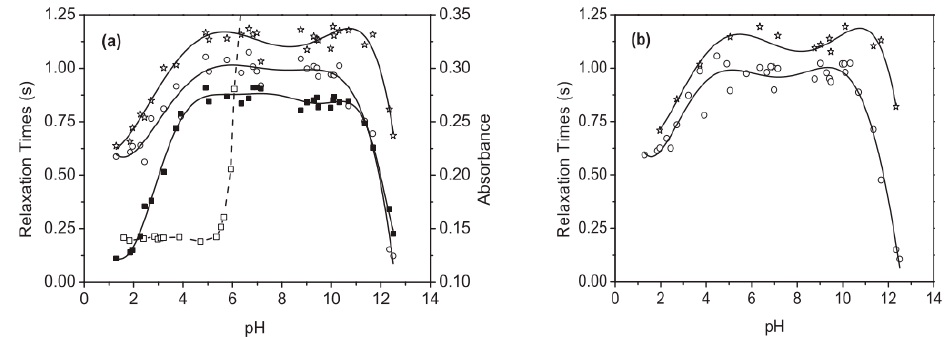
Figure 13. ( A ) Variation in maximum absorbance at 730 nm ( ■ ), T 1 ( ☆ ) and T 2 ( ○ ) measured